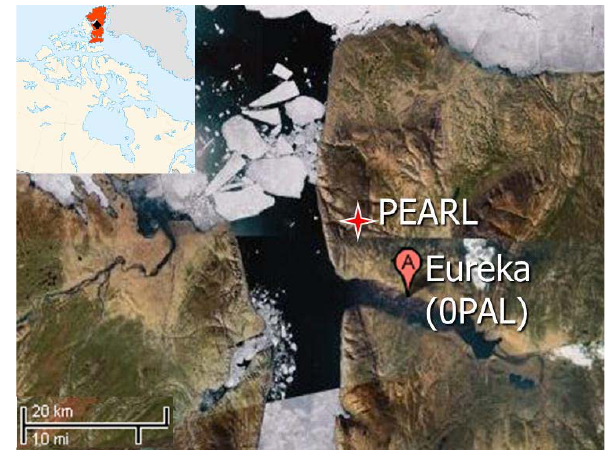
Fig. 1. Satellite composite image of Eureka on Ellesmere Island (in- sert: highlighted in red, black diamond is Eureka), Nunavut, Canada in the early summer. The PEARL Ridge Lab and 0PAL are sepa- rated by 15km and their locations are indicated on the image. Im- age: © 2013 Google, © 2013 TerraMetrics, © 2013